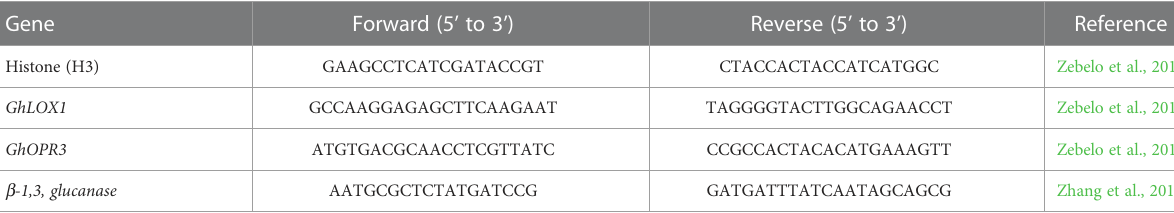
TABLE 1 Primers for GhLOX1 , GhOPR3 and b -1,3, glucanase . Gene